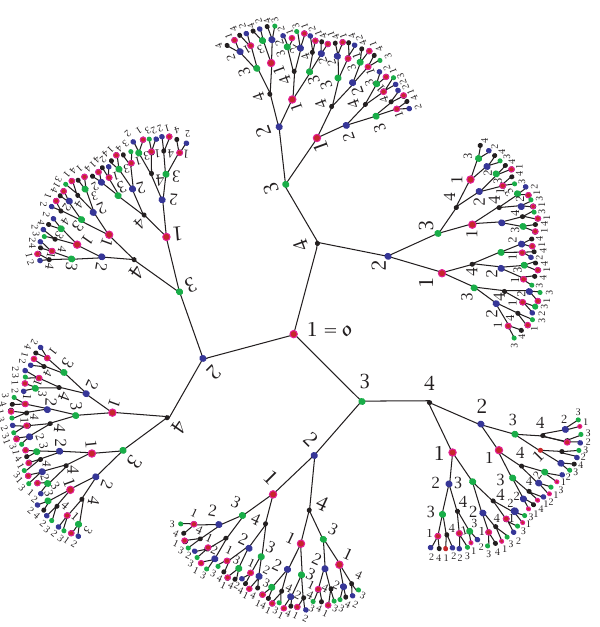
Figure 3.2 . Another view of the tessellation in Figure